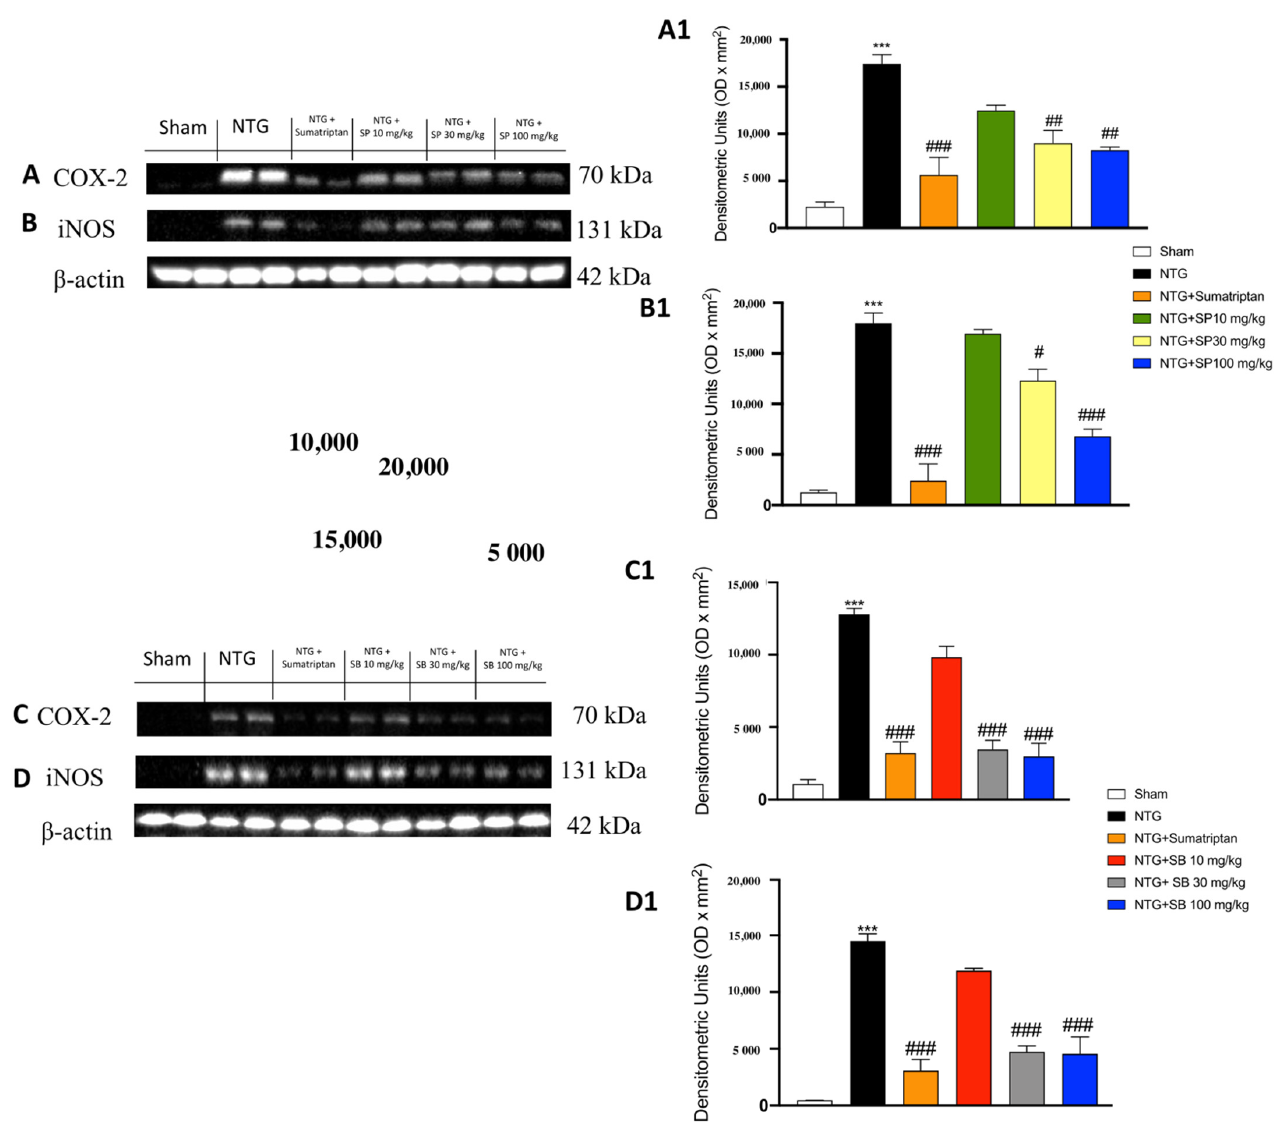
Figure 3. SCFAs administration reduces pro-inflammatory enzymes in NTG-injected mice. Western blot analysis of iNOS and COX-2 shows an increased expression in the NTG groups compared to the sham animals ( A , A1 , B , B1 , C , C1 , D , D1 ). SCFAs of 10 mg/kg are not able to reduce the expression of COX-2 and iNOS; SCFAs at the two highest doses significantly reduce these expressions as well as sumatriptan administration ( A , A1 , B , B1 , C , C1 , D , D1 ). Data are representative of at least three independent experiments; one-way ANOVA test. *** p < 0.001 vs. sham; # p < 0.05 vs. NTG; ## p < 0.01 vs. NTG; ### p < 0.001 vs. NTG. N = 10 mice/group for each technique.